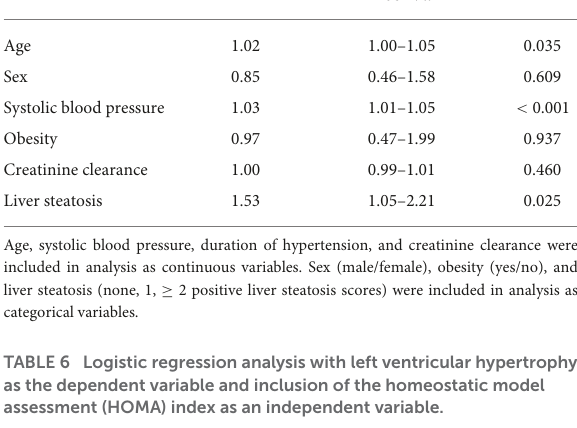
TABLE 5 Logistic regression analysis with left ventricular hypertrophy as the dependent variable. Variable